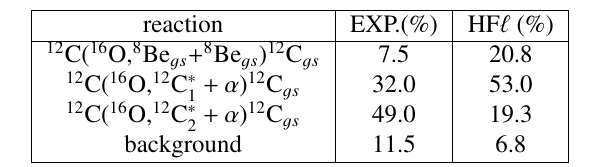
corresponds to the Hoyle state, 1 C ∗ to 9.64 2